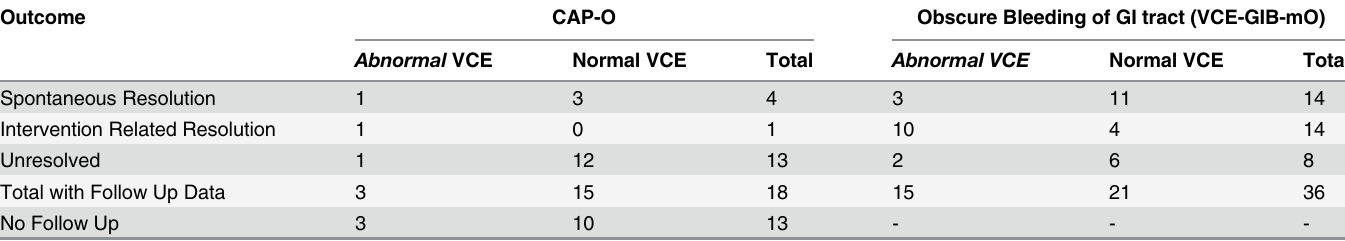
Table 4. Sensitivity Analysis for chronic abdominal pain without associated